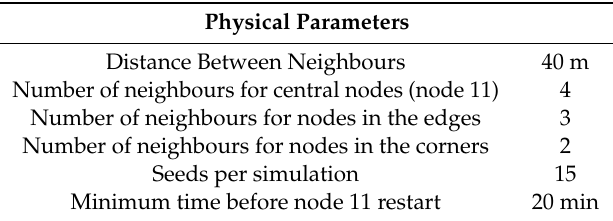
Table 3. Simulation configuration.